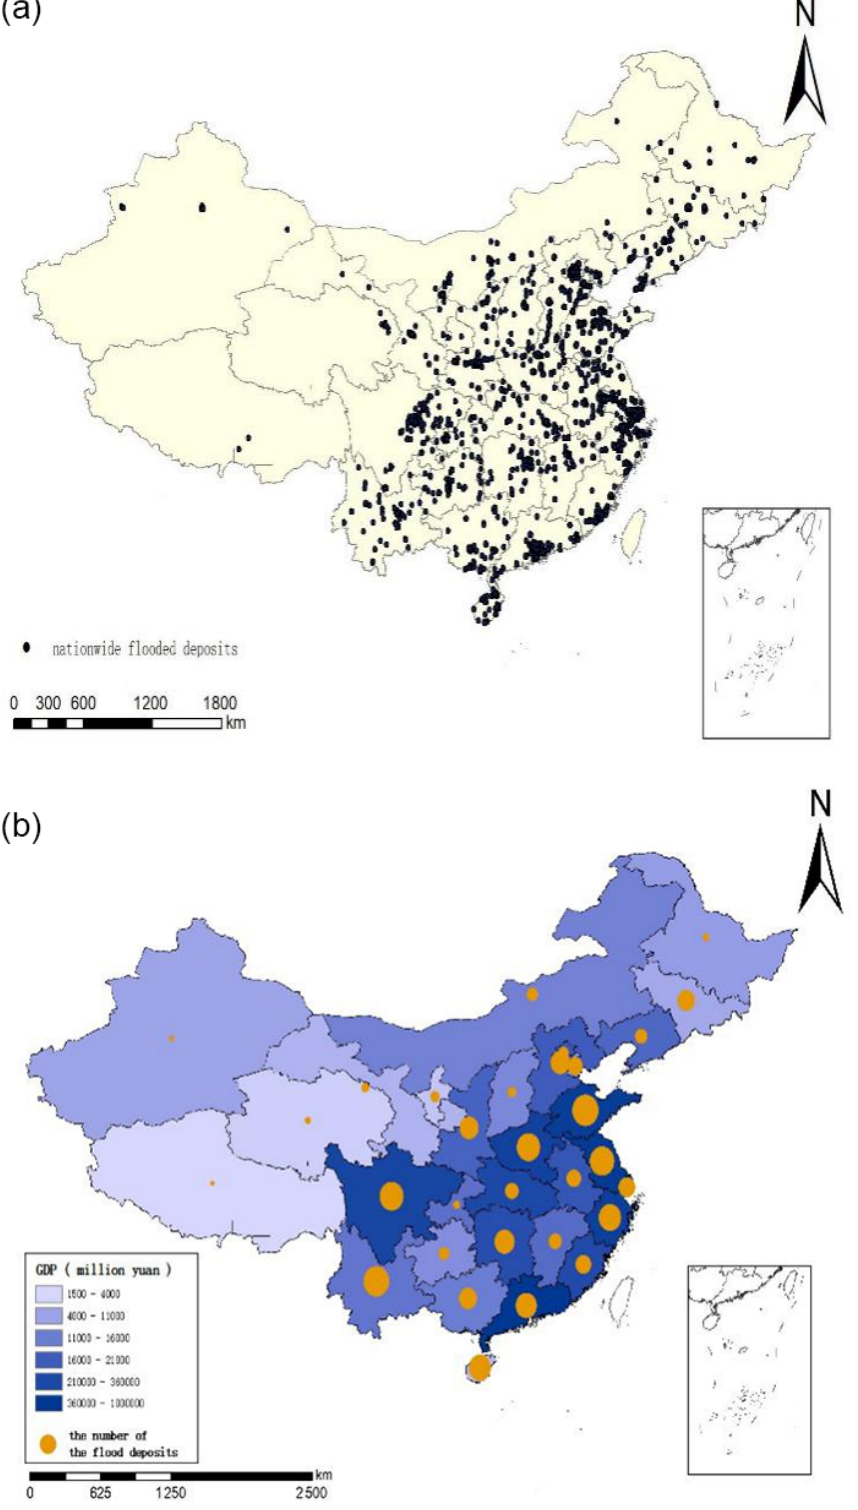
Figure 8. Nationwide map of waterlogging: flood deposit image (a) , image of the number of flood deposits (b)